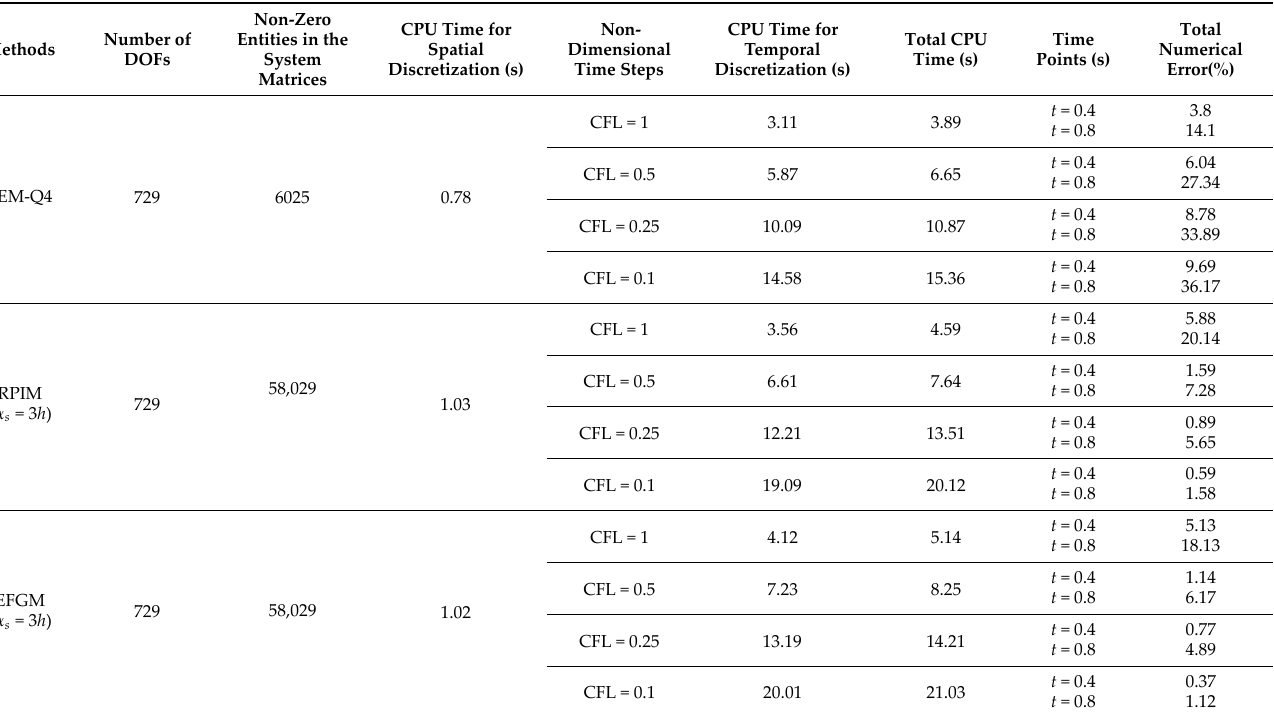
Table 1. The detailed computational cost of different numerical methods in solving the numerical experiment in Section